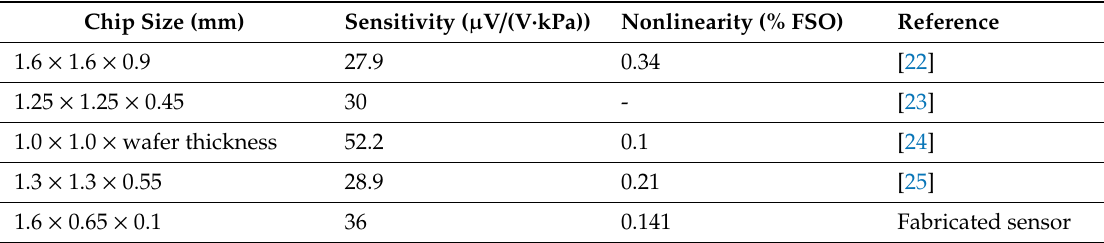
Table 2. Comparison with other miniature pressure sensors.